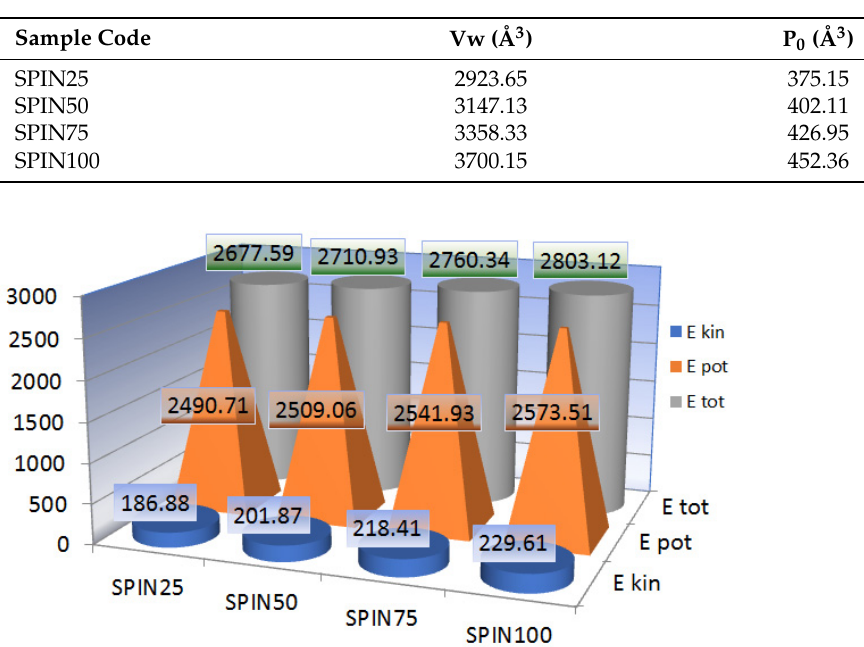
Table 2. Van der Waals volume and polarizability computed for the PI-based supramolecular systems.